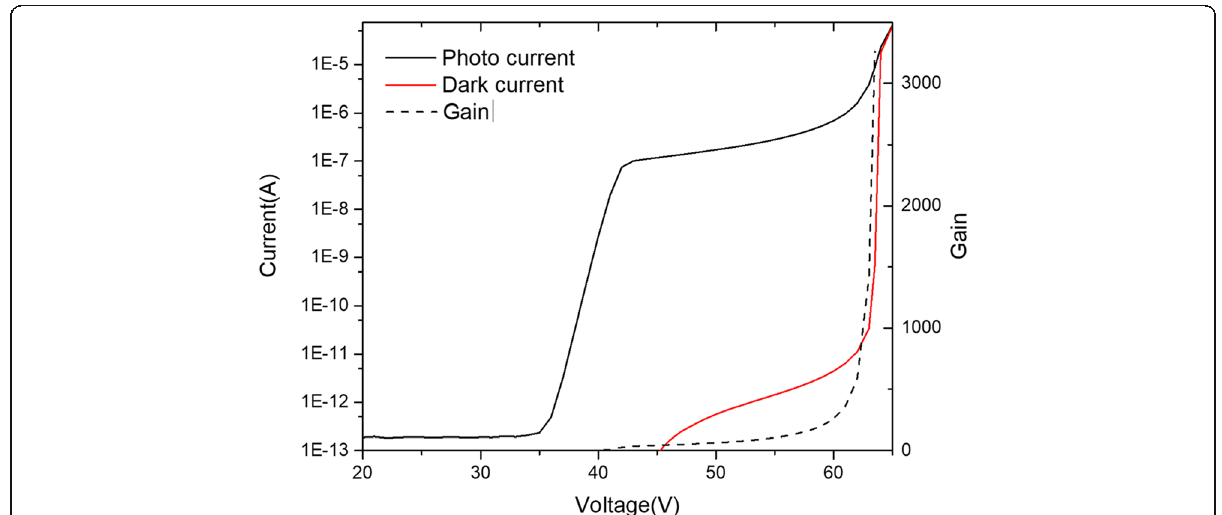
Fig. 3 Current-voltage curve along with gain vs voltage of InGaAs/InAlAs APD. Presents the i-v curve along with gain vs voltage curve for some typical device structure as